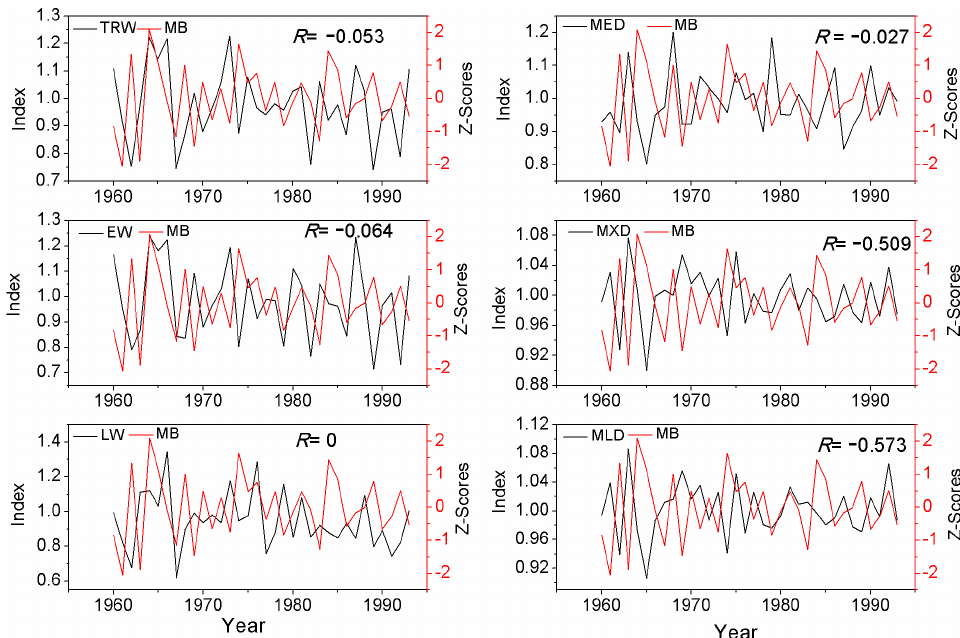
Fig. 4. Comparisons of the residual chronologies of the six tree-ring parameters with the mass balance data over the period 1960–1993. TRW: tree-ring width; EW: earlywood width; LW: latewood width; MED: mean earlywood density; MXD: maximum latewood density; MLD: mean latewood density.